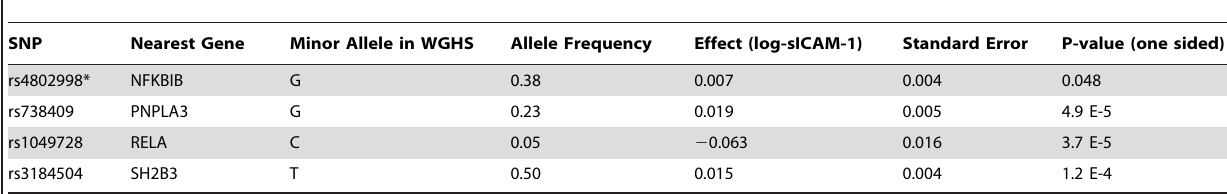
Table 3. Replication of novel loci in CHARGE (N